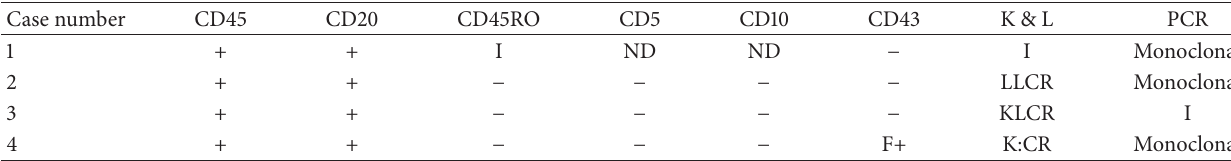
Table 2: Immunohistochemical and polymerase chain reaction (PCR) findings ∗